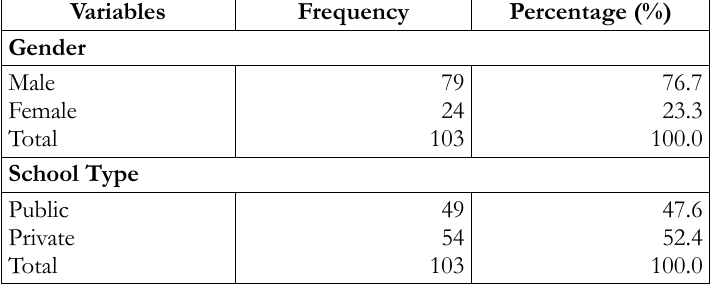
Table 1. Demographic Distribution of Respondnts